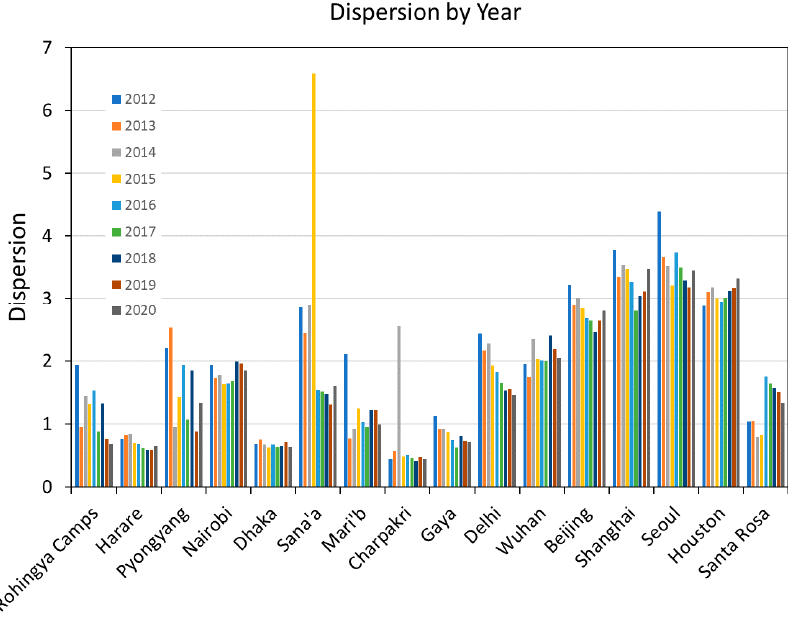
Figure 39. Picket-fence chart of the mean dispersion for each of the test